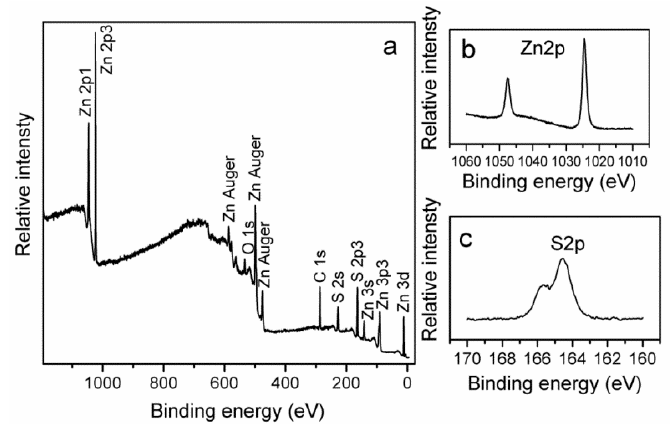
Figure 4. The XPS analysis of ZnS nanostructures ( a ) Core shell scan XPS spectrum of sample, ( b ) Zn 2p XPS spectrum, ( c ) S 2p XPS